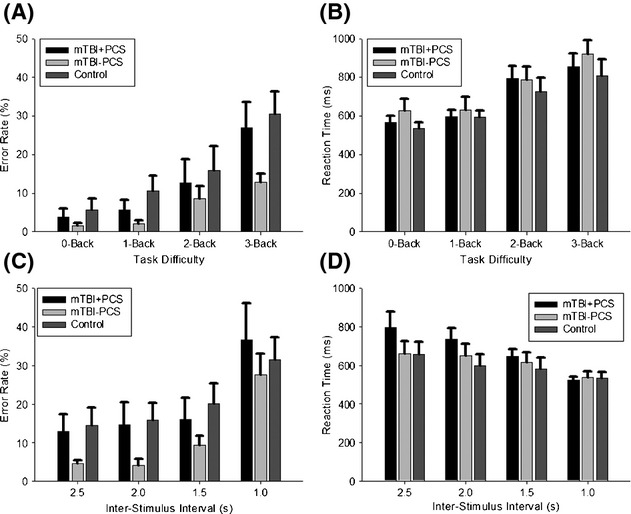
Behavioral data illustrating n-Back error rate (A) and reaction time (B), as well as PVSAT error rate (C) and reaction time (D). Bar graphs represent mean±SEM.